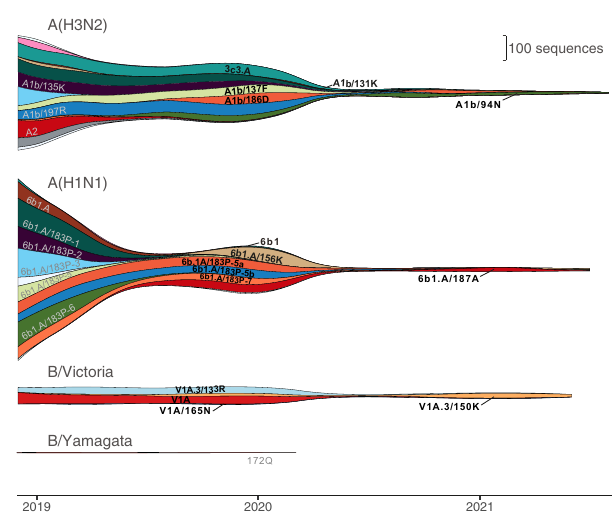
Fig. 1 Streamgraph showing temporal changes in in fl uenza